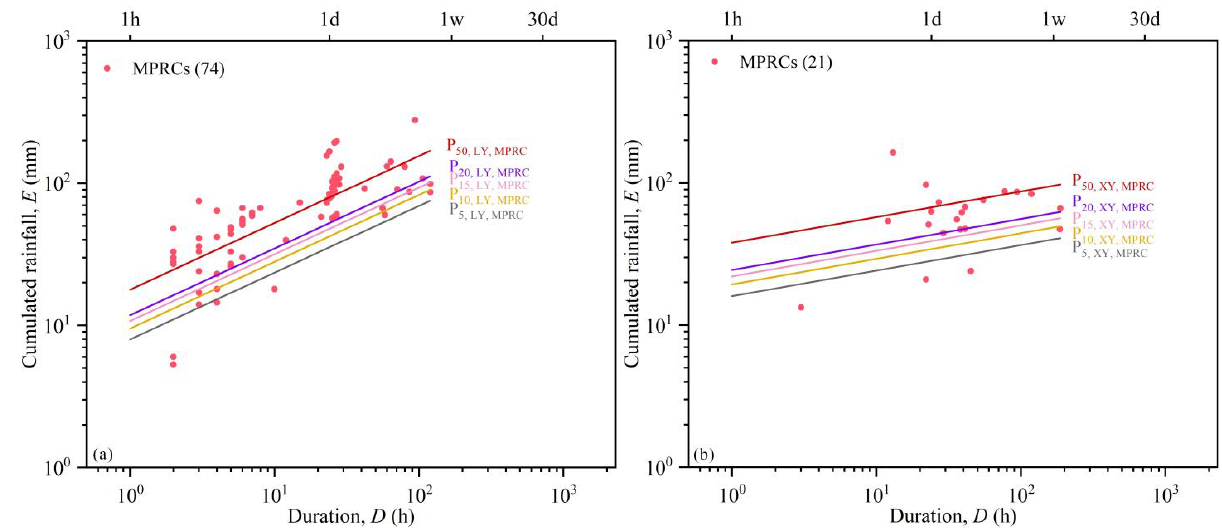
Figure 6. Defined positive rainfall thresholds based on MRC: ( a ) LY county; ( b ) XY county.